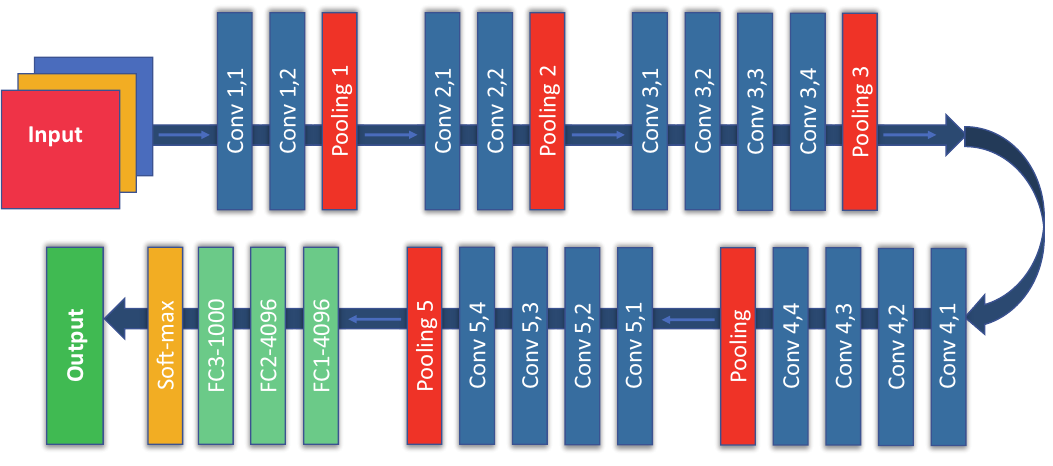
Figure 4. The architecture of